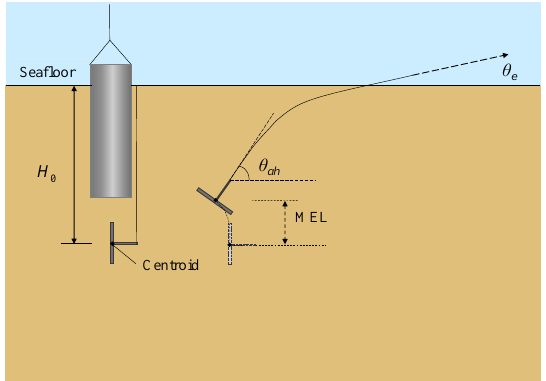
Figure 17. Installation, keying, and embedment loss of a SEPLA.